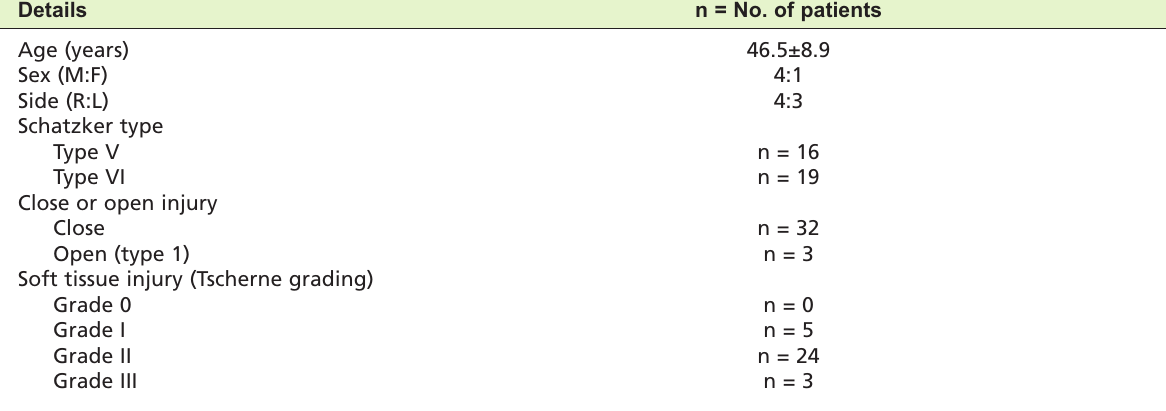
Patient demography and types of Table III: